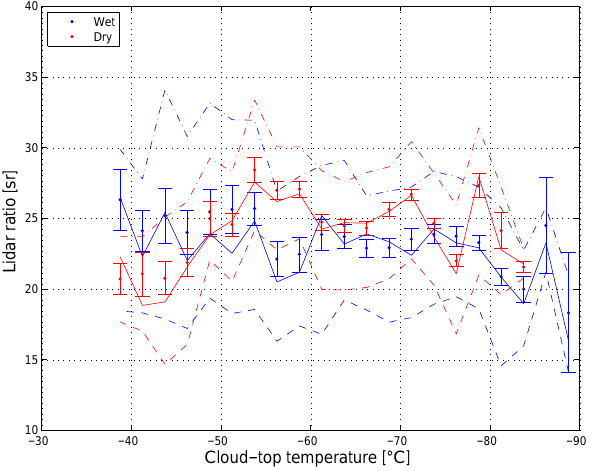
Figure 9. Dependence of the corrected lidar ratio with cloud-top temperature is shown for the wet (blue) and dry (red) seasons. The markers give mean and standard deviation of the mean. The contin- uous and dashed lines give median and interquartile distance. Tem- perature is divided into 2.5 ◦ C